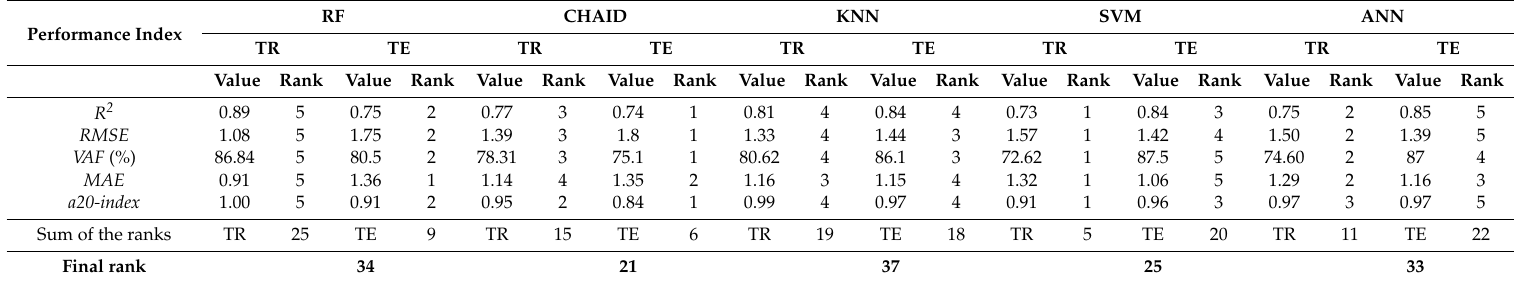
Table 2. Evaluation of Models Developed Using Five Performance